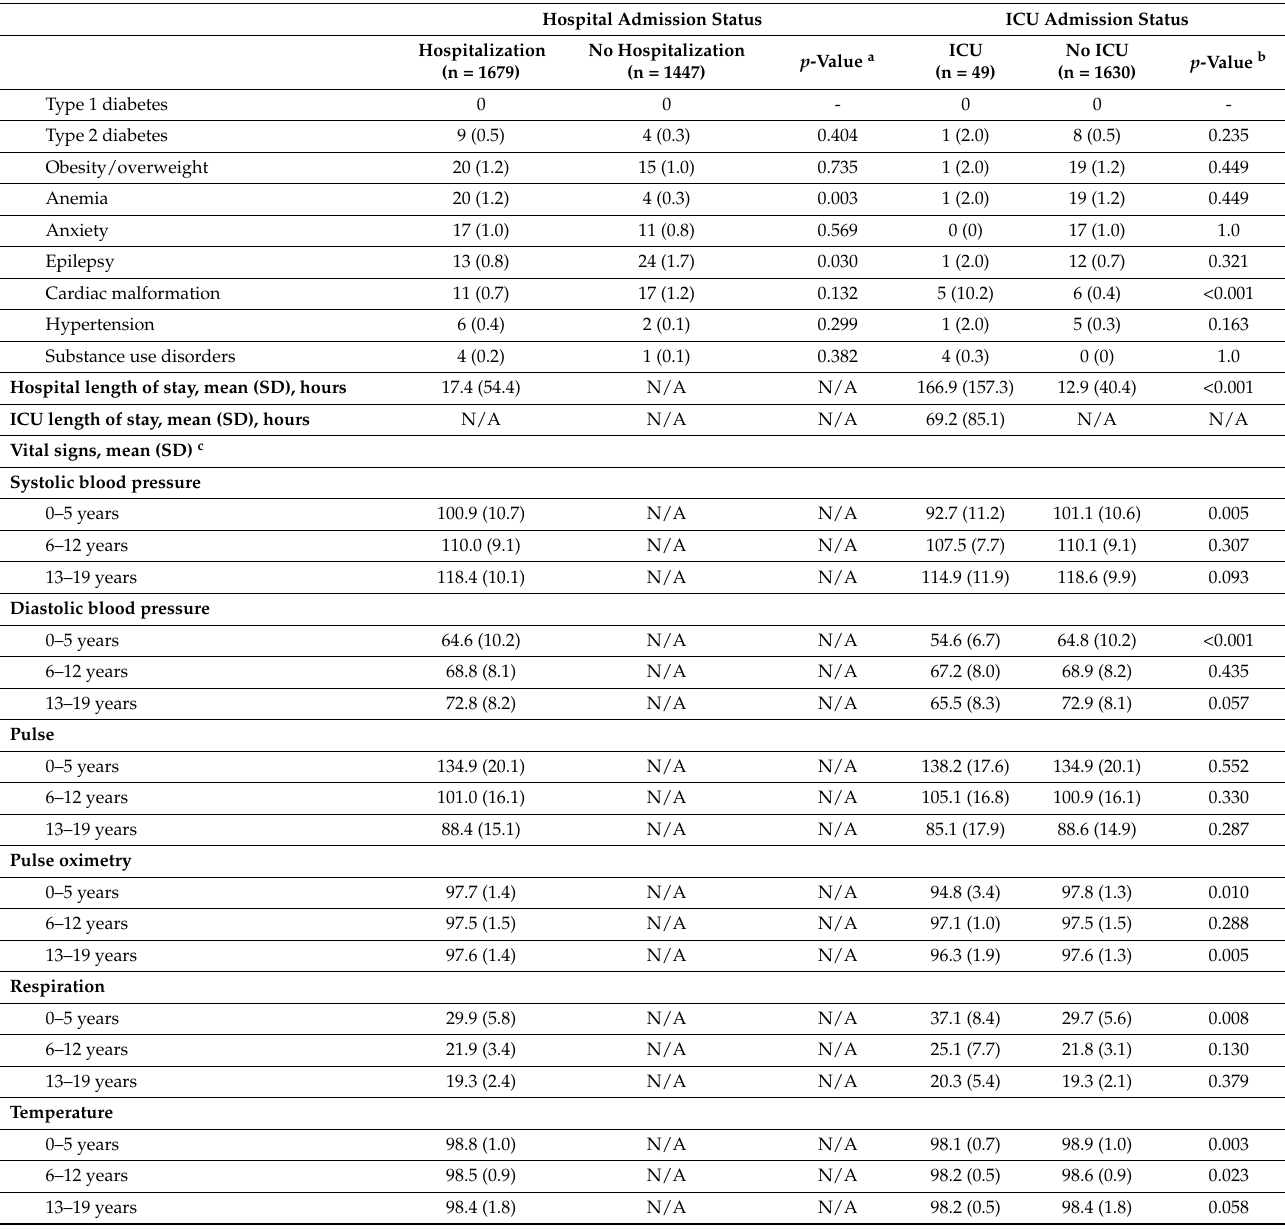
from community primary care clinics were not available for our